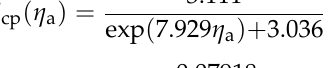
Figure 10. Mean and variance of crushed products under different single-layer crushing conditions: ( a ) Mean of crushed products; ( b ) Variance of crushed products.